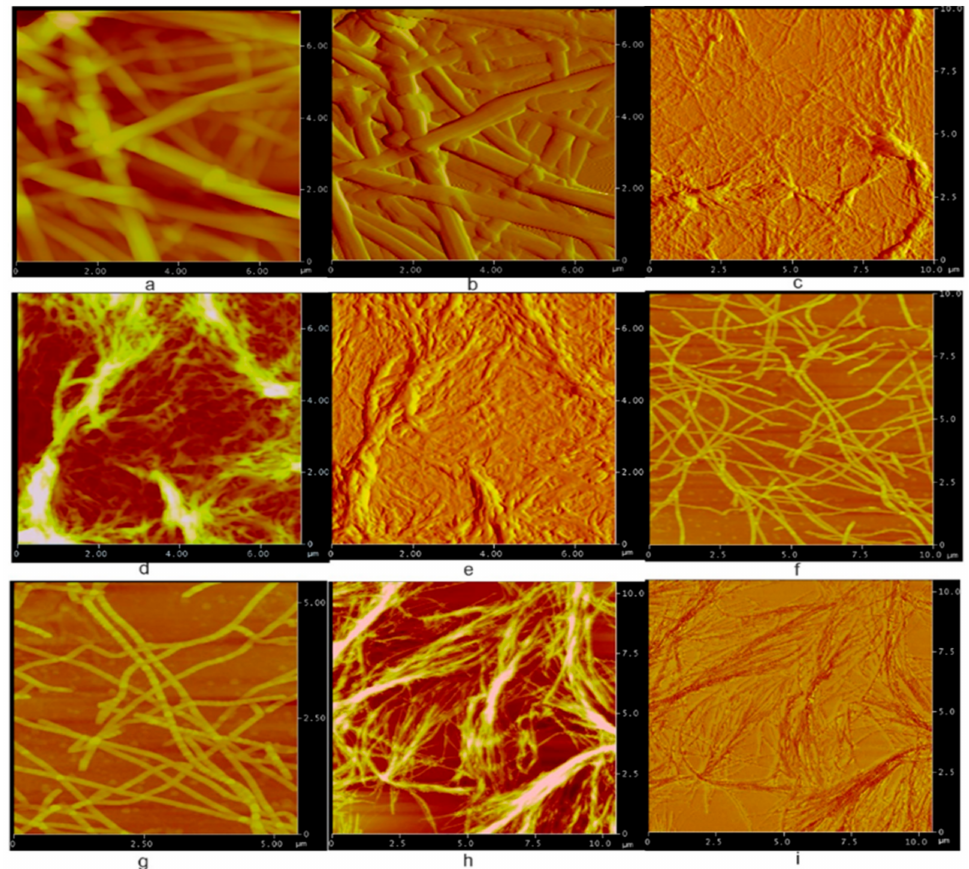
Figure 5. AFM images of the gels formed by gelators 11 – 13 , ( a , d , f , g , h ) are height images, and the rest are phase images. ( a , b ) 11 in DMSO/H 2 O ( v / v 1:2) at 2.0 mg/mL; ( c – e ) 12 in EtOH/H 2 O ( v / v 1:1) at 2.0 mg/mL; ( f , g ) 13 in DMSO/H 2 O ( v / v 1:1) at 1.0 mg/mL; ( h , i ) 13 in EtOH/H 2 O ( v / v 1:1) at 1.0